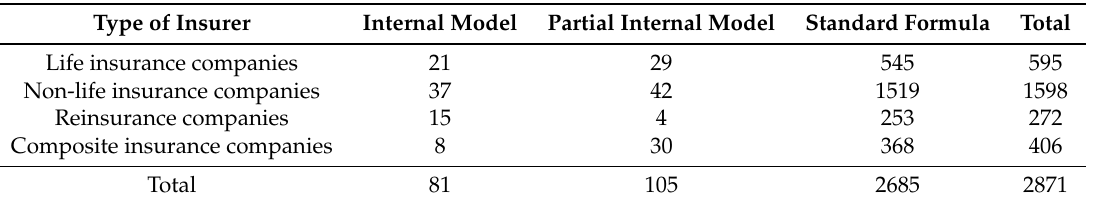
Table 1. Number of Solvency II submissions (solo undertakings) in 2017 by the method used for calculation of the Solvency Capital Requirement (SCR). Data source: